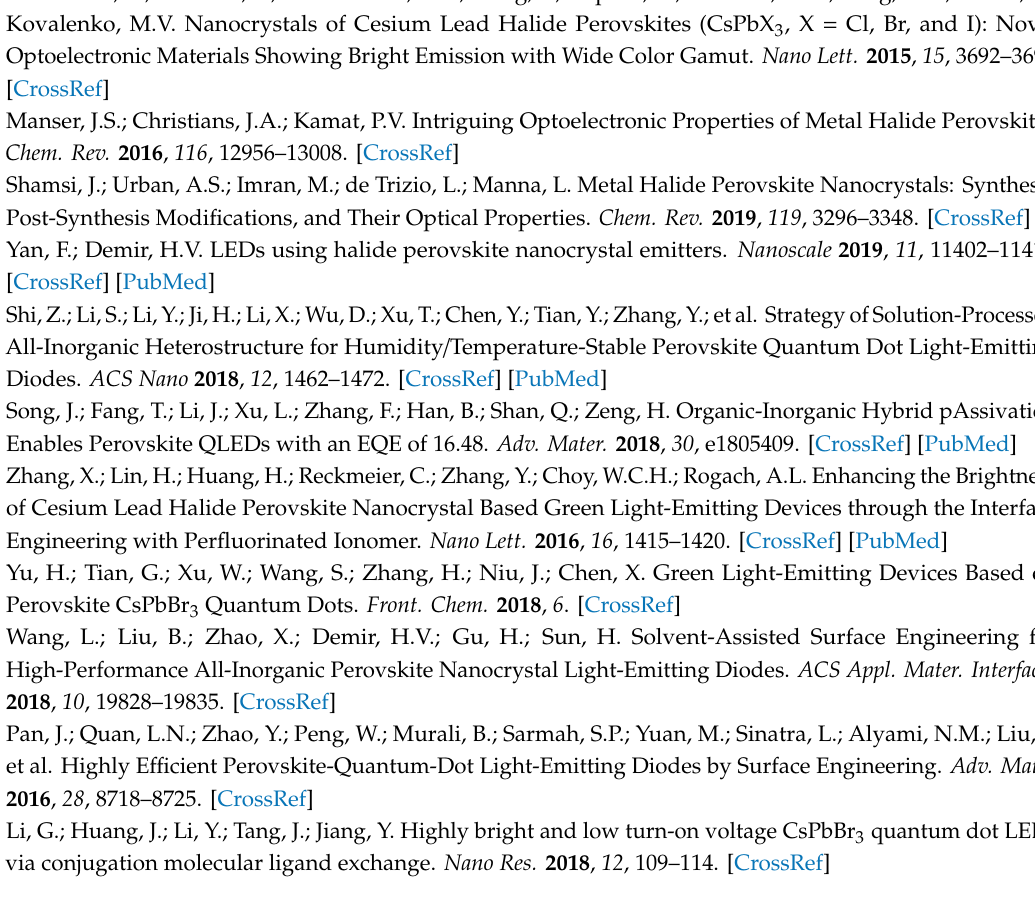
Figure S1. TEM images and size distributions of NCs in (a,b) 0SCN, (c,d) 10SCN, (e,f) 30SCN, and (g–k) 50SCN NC solutions. Comparison of (i) fitted average size with FWHM of fitting peaks as error. (j) XRD pAtterns of the NCs; Figure S2. SEM cross-section of (a) 10SCN; (b) 30SCN; and (c) 50SCN devices. From bottom to top, the layers include ITO / PEDOT:PSS + poly-TPD (~60 nm) / CPB NC (~30 nm) / TPBi (~45 nm); Figure S3. (a) Current density of 30SCN device as a function of driving voltage; (b) EL spectra of 30SCN device at di ff erent driving voltages; Figure S4. Comparison of (a) current density as a function of driving voltage; (b) EQE, (c) luminescence of 0SCN and 30SCN fresh and aged devices as a function of current density; (d) EL spectra of 0SCN and 30SCN aged devices; Figure S5. (a) Visible light absorption plots; (b) PL; (c) decay lifetime; and (d) fitted decay lifetime and PLQY of NC films on PEDOT:PSS / Poly-TPD substrates; Figure S6. Comparison of average current of 10SCN and 30SCN NC films at di ff erent applied voltages; Figure S7. EL positions of fresh and aged devices in a CIE coordinate system; Figure S8. Comparison of (a) EL peaks and (b) FWHM of the EL peaks of fresh and aged devices. EL spectra of 30SCN (c) fresh and (d) aged devices; Figure S9. Statistics of (a) maximum EQE, (b) maximum luminescence, (c) maximum current e ffi ciency, and (d) current density at the maximum EQE of aged devices; Figure S10. (a) EL spectra and (b) evolution of the EL peaks collected during operation stability test of 30SCN aged device; Table S1. Summary of LED performance in literature; Table S2. Statistics of LED performance of the fresh and aged devices; Table S3. Statistics of performance of 41 aged 30SCN-based